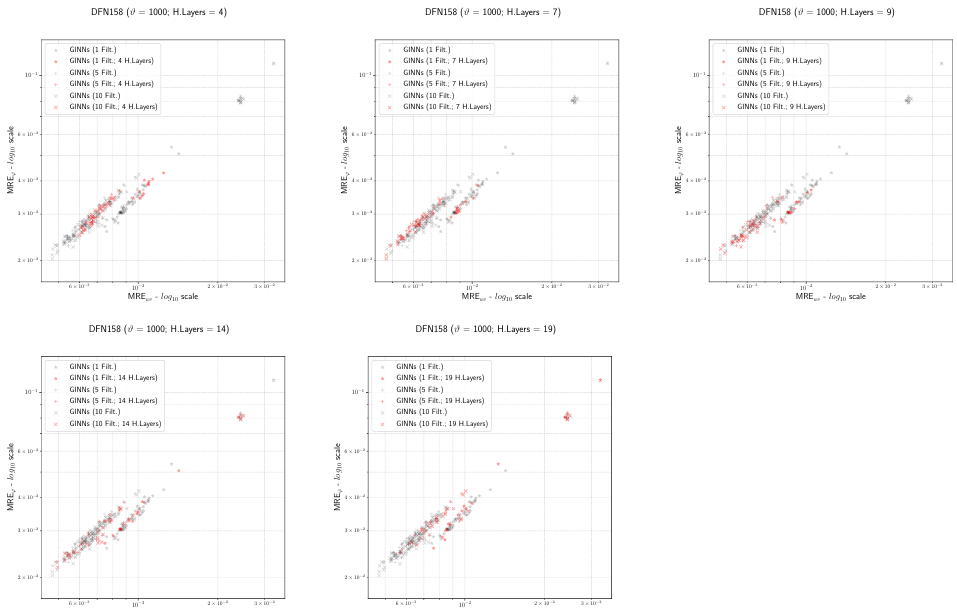
Figure 13. Scatter plots in the ( MRE av ,MRE ϕ ) plane for GINNs trained with respect to DFN158, ϑ = 1000. Left to right, top to bottom: red markers highlight GINNs trained with H = 4,7,9, 14,19, respectively (black markers for all the other models).